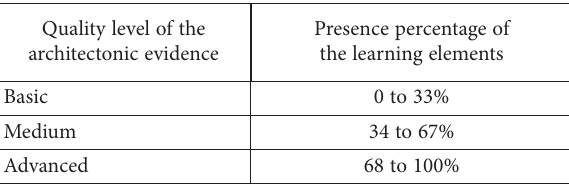
Table 4. Qualify scale in relation to the presence of architectonic learning components (source: Authors, 2019)